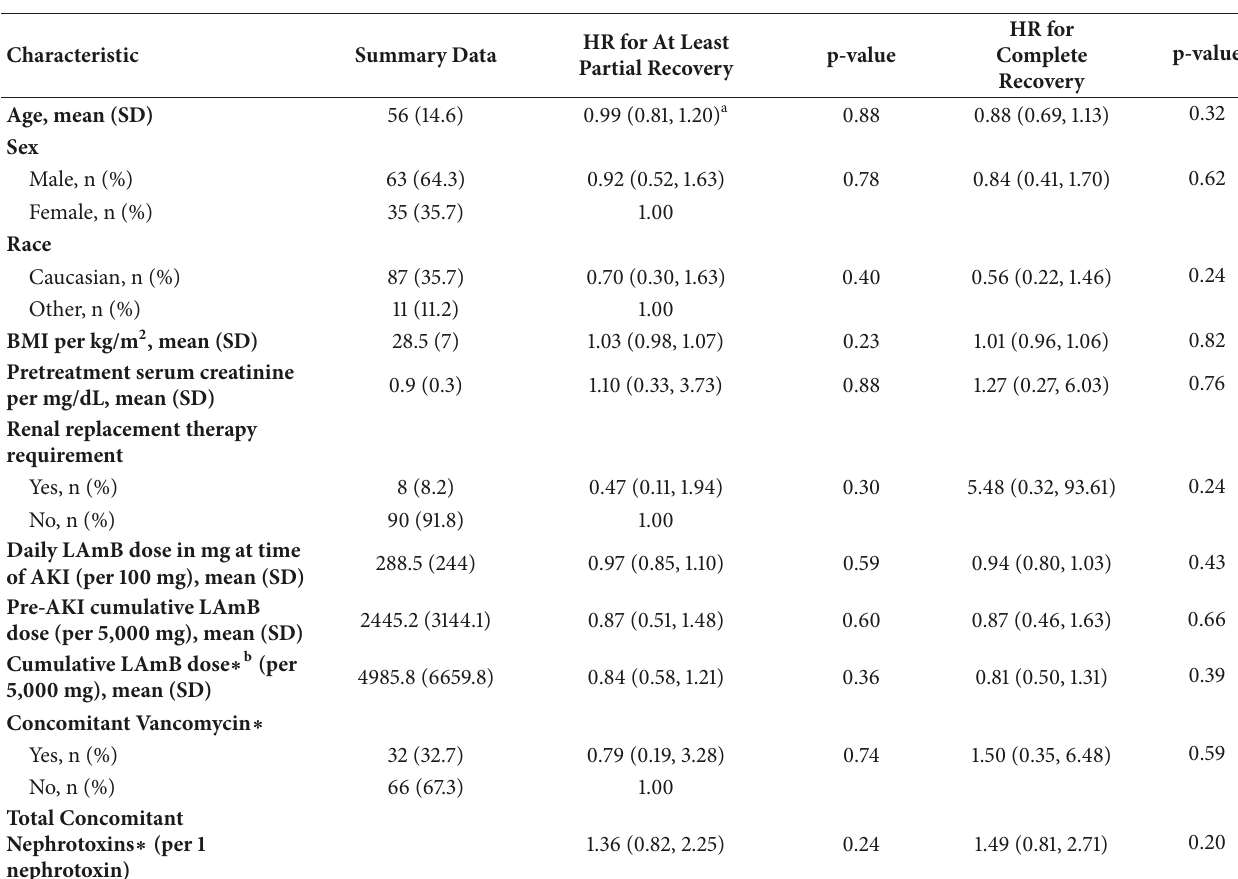
Table 2: Univariate Cox